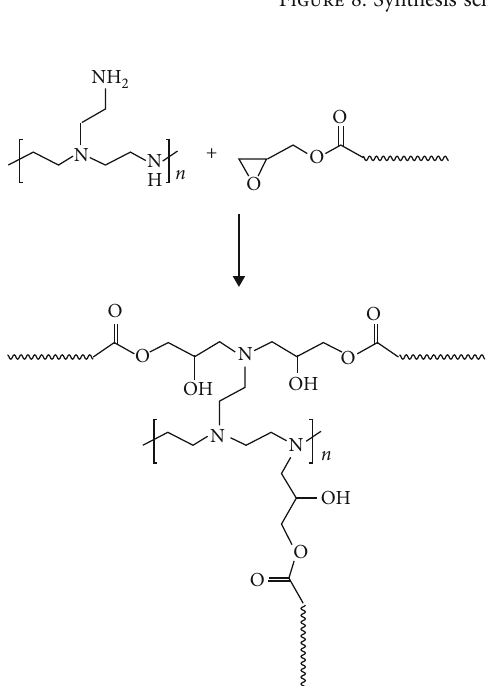
Figure 8: Synthesis scheme of gelatin-dopamine conjugate [53].